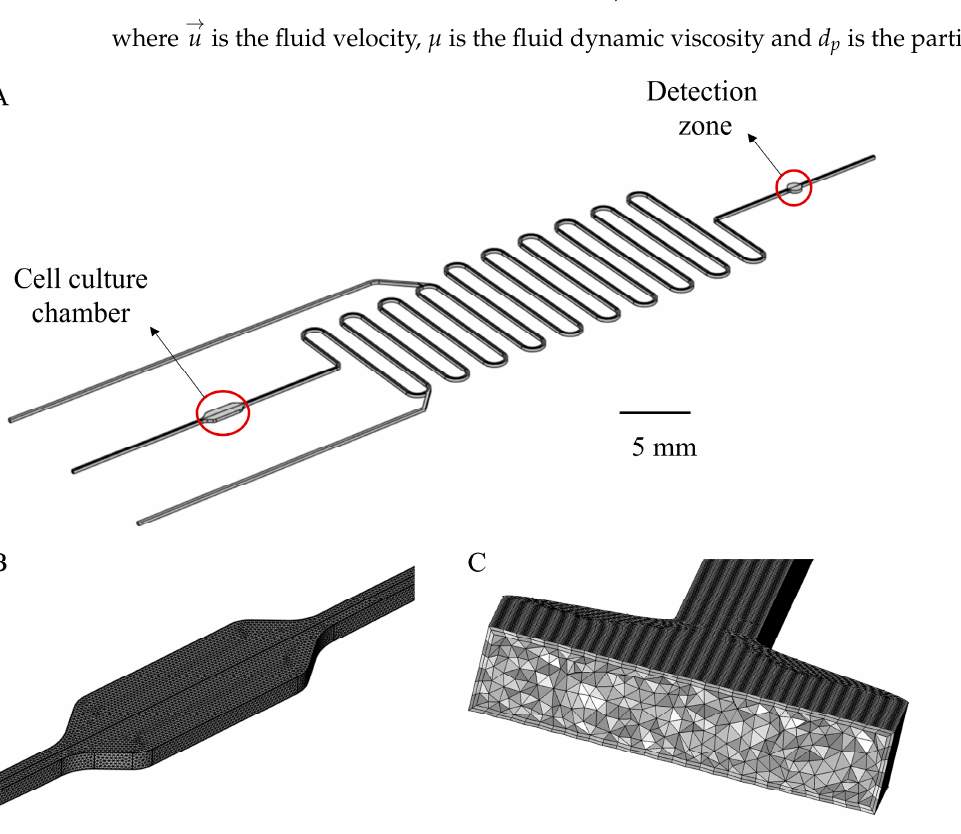
Figure 2. ( A ) Geometry of the Simulation model. The channel size is 200 µm × 200 µm (height × width). The width of the cell culture chamber is 1 mm and the length is 3 mm. The diameter of the detection zone is 1 mm. ( B ) Grid division detail of cell culture chamber and ( C ) enlarged cross-sectional view of the grid. Tetrahedral and boundary layer mesh were employed for automatic meshing.